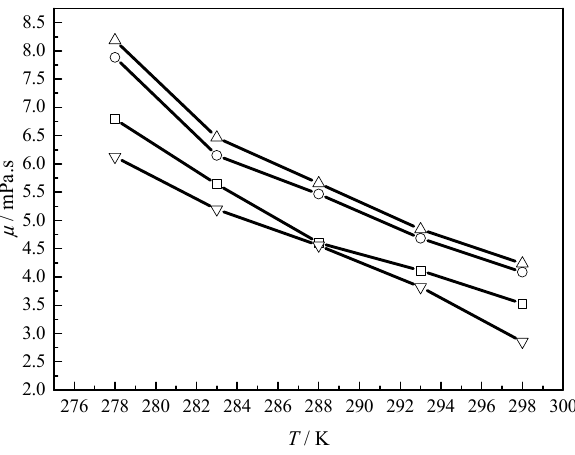
Figure 4. Viscosity of ( ▽ ) diesel oil and water-in-oil emulsion with AA-4 for water cut of ( □ ) 5 vol %; ( ○ ) 10 vol %; ( △ ) 15 vol %. Lines are provided to guide the eye.